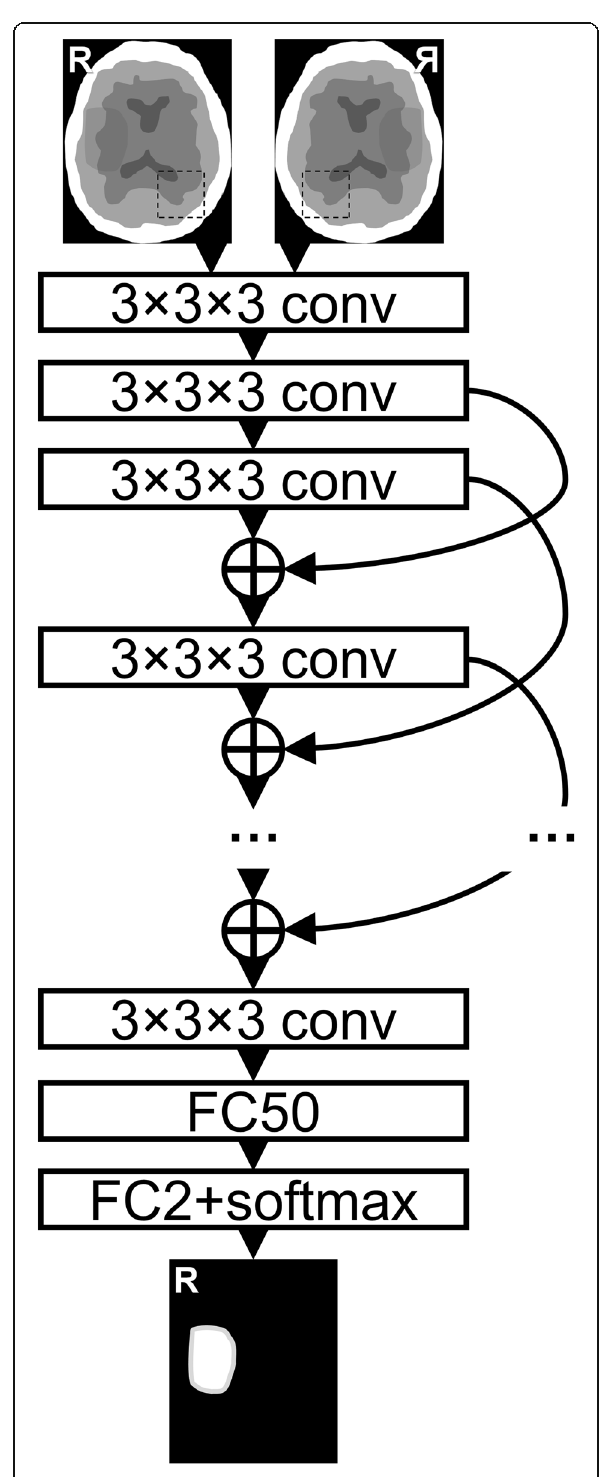
Fig. 1 The neural network architecture consisted of 40 three- dimensional convolutional layers (conv) with valid padding and exponential linear unit activation. Skip-connections (curved arrows) with concatenations (+) were used with appropriate cropping. These were followed by two fully connected layers (1 × 1 × 1 convolutions, FC) with 50 and 2 output neurons, and rectified linear unit and softmax activation, respectively. In the end, the predicted patches were stitched together to produce a lesion segmentation of the same size as the